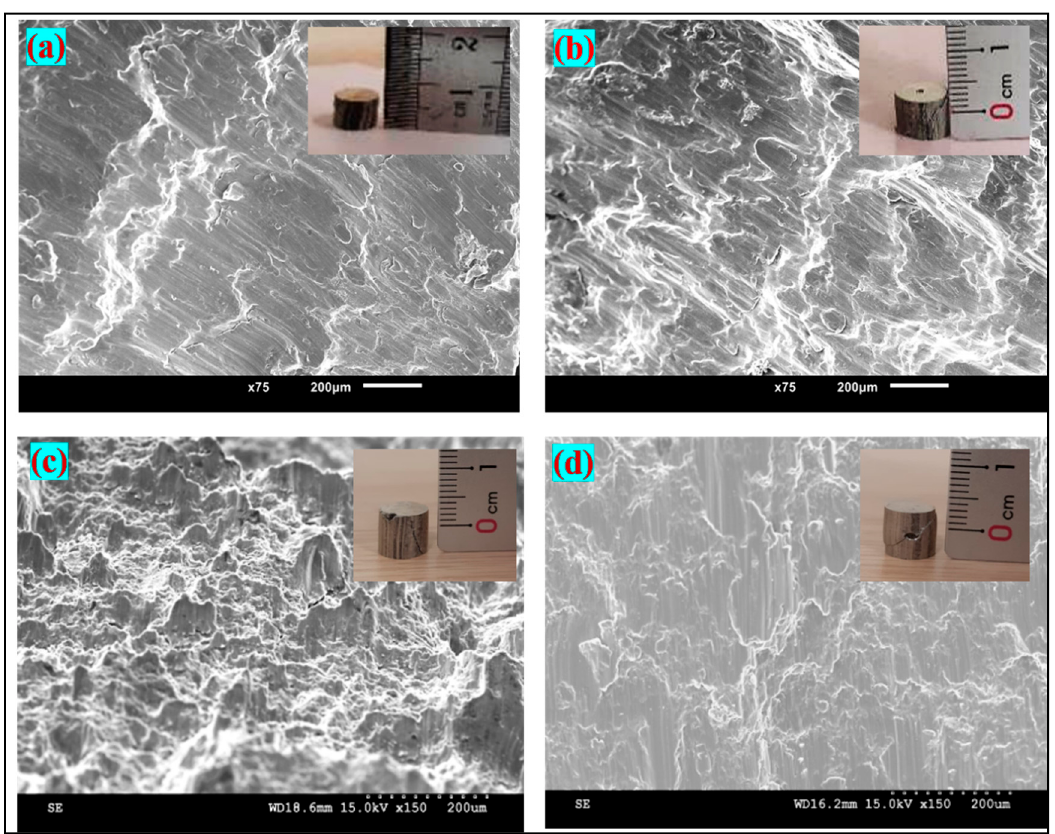
Figure 10. Compressive fracture surface for ( a ) monolithic Mg, ( b ) vertical drill hole orientation, ( c ) angular drill hole orientation and ( d ) horizontal drill hole orientation with insets showing the respective fractured specimen.